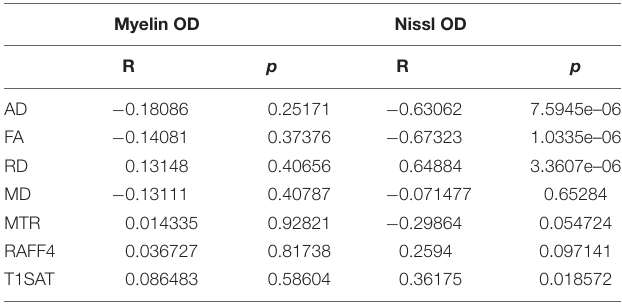
TABLE 2 | Correlation between MRI metrics and the OD of myelin- and Nissl-stained sections. Myelin OD Nissl